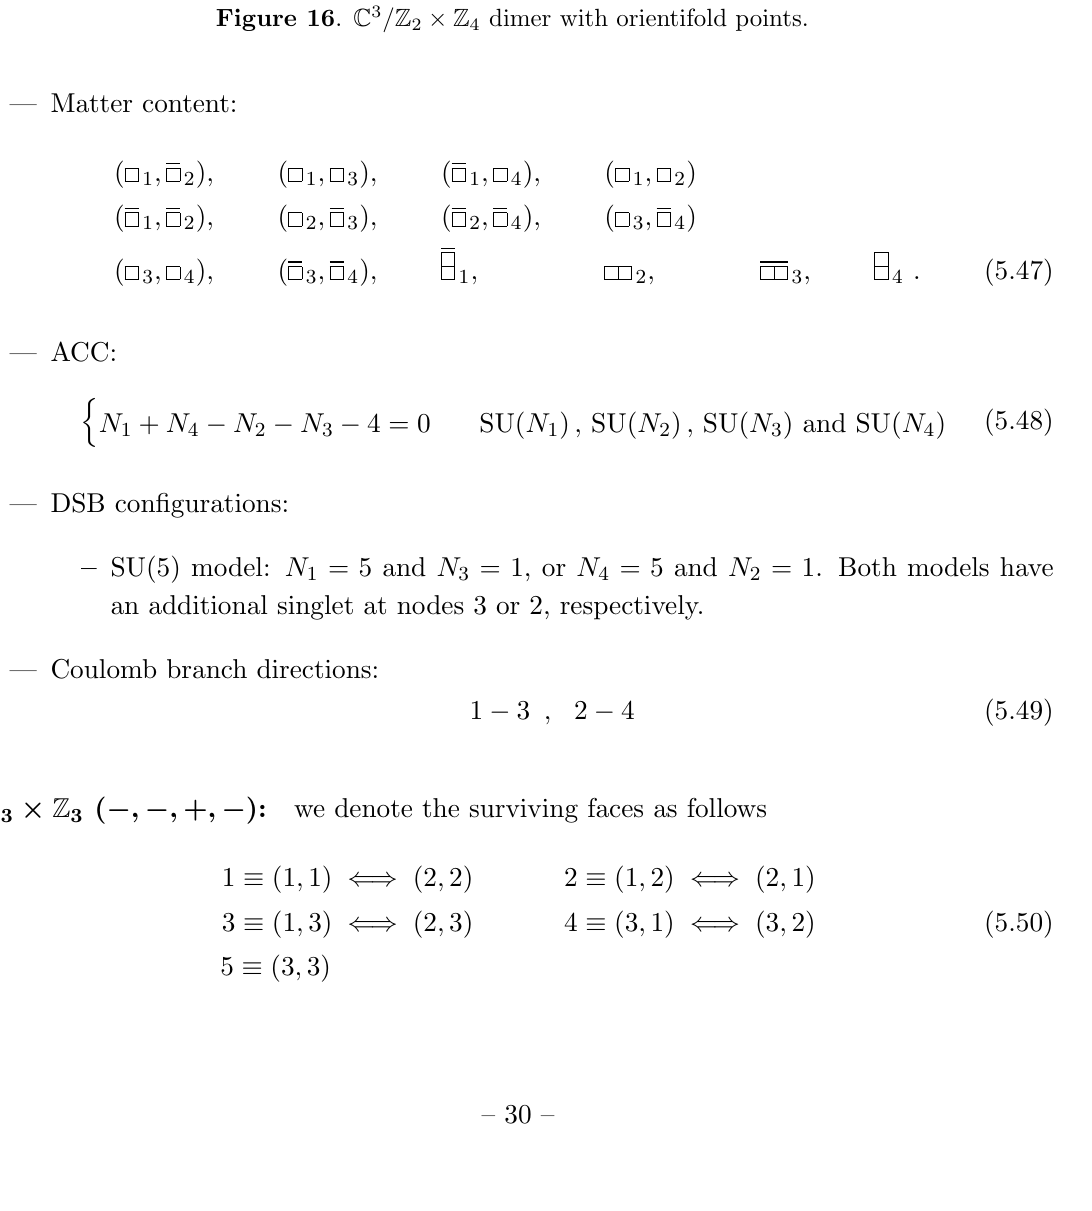
Figure 16 . C 3 = Z